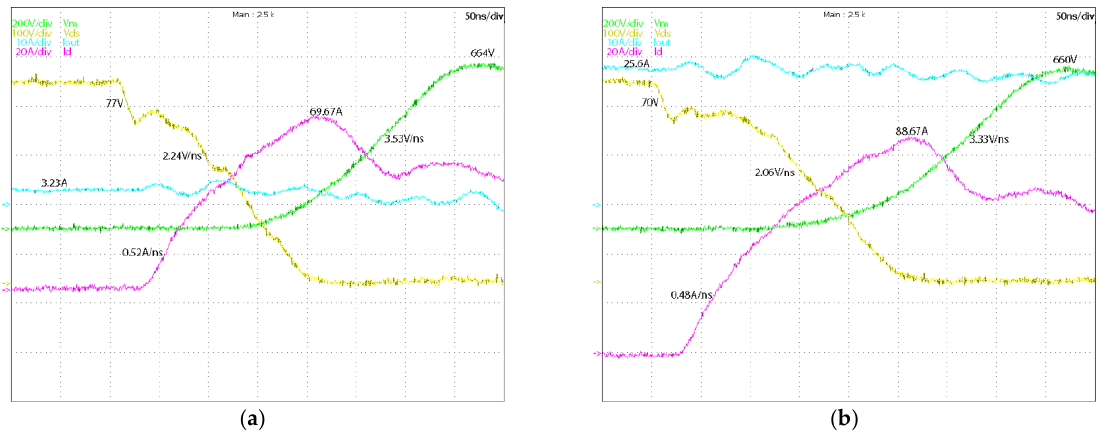
Figure 11. Turn-on of S A,t located in the three-phase S2L inverter with R G = 4.7Ω, C SA,t = 9.4 μF dead-time DT = 1 μs, switching frequency f sw = 10 kHz and l C = 15 m: ( a ) phase current of 3.23 A, ( b ) phase current of 25.6 A. Line-to-line voltage V m at the motor side (green track), drain-source voltage V DS of the S A,t (yellow track), drain current of S A,t (magenta track) and phase current I A (ciano track).